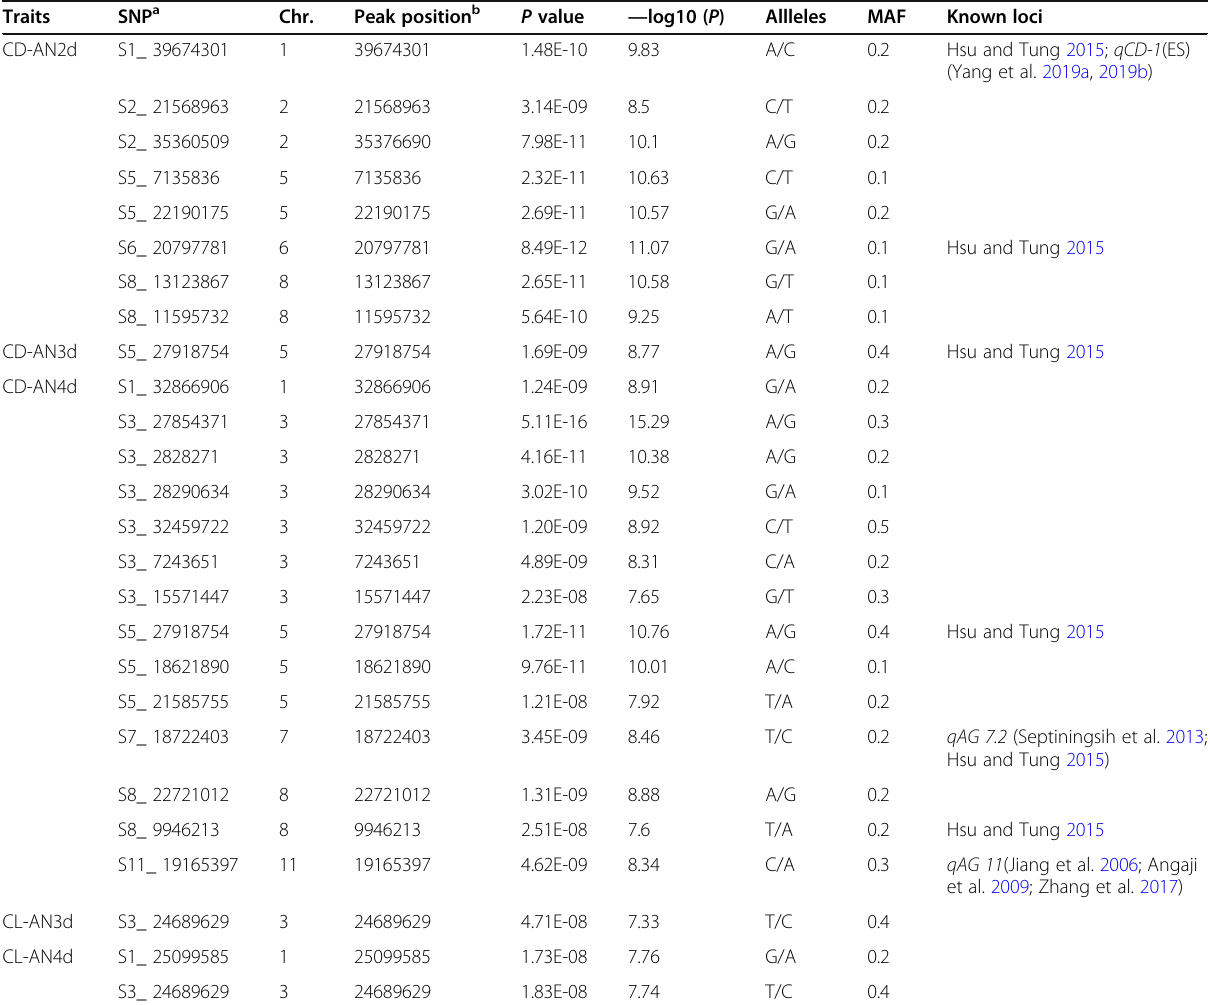
Table 3 Genome-wide significant associations for coleoptiles phenotype under anaerobic germination (AG) using MLM Traits